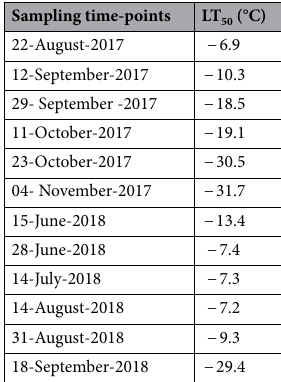
Table 1. The estimates of LT 50 , calculated by fitting sigmoidal curve to electrolyte leakage values of temperature treatments, recorded for leaves collected during the different sampling time-points (from August 22, 2017 to September 18,